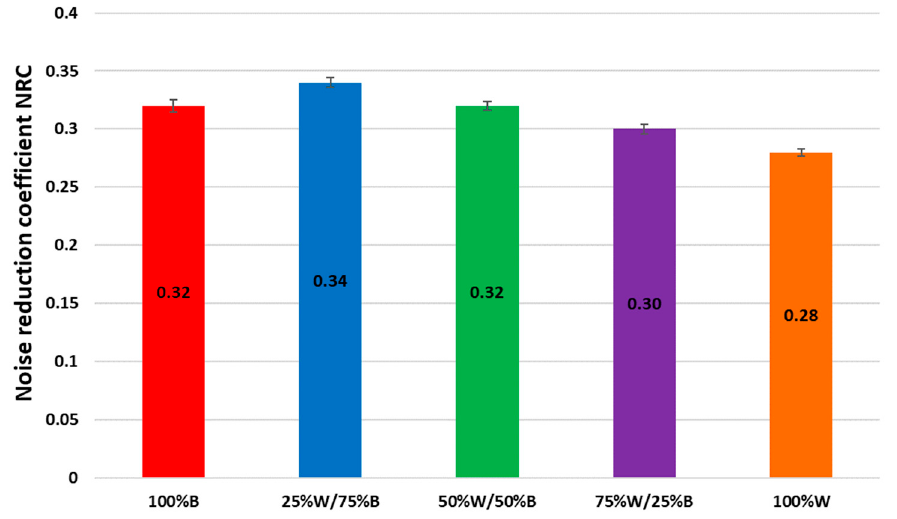
Figure 2. Sound absorption coefficient, α .